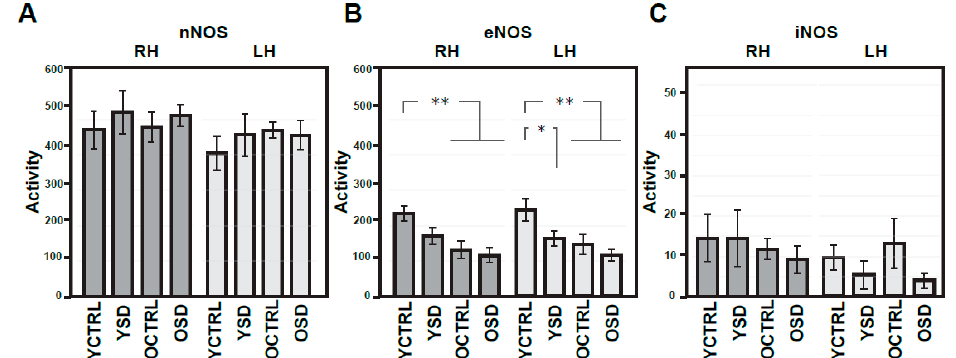
Figure 7. Comparison of activities of NO synthases in the right and left parietal cortex of young adult and old rats exposed to chronic sleep deprivation (experiment III). Summary histogram of activities of NOS isoforms ( A – C ) expressed as nmoles/30 min/mg of proteins. Results are presented as means activities of NOS isoforms ( A – C ) expressed as nmoles / 30 min / mg of proteins. Results are presented ± SEM. Statistical significance (Student´s t -test) was calculated with respect to young adult controls (*